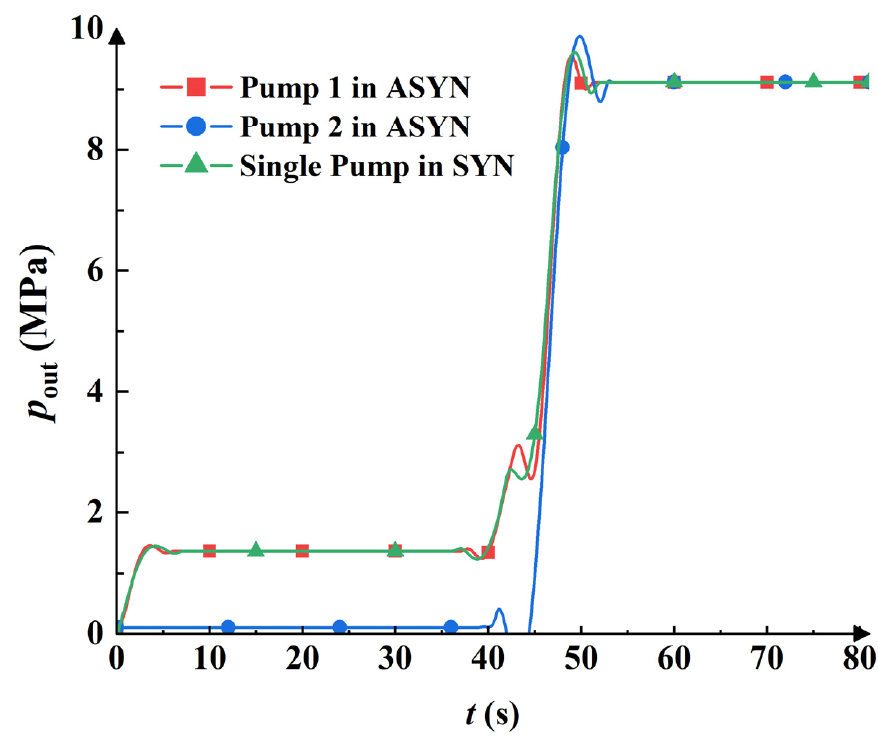
Figure 11. Comparison of pump outlet pressure in Scheme ASYNC vs. Scheme SYNC.